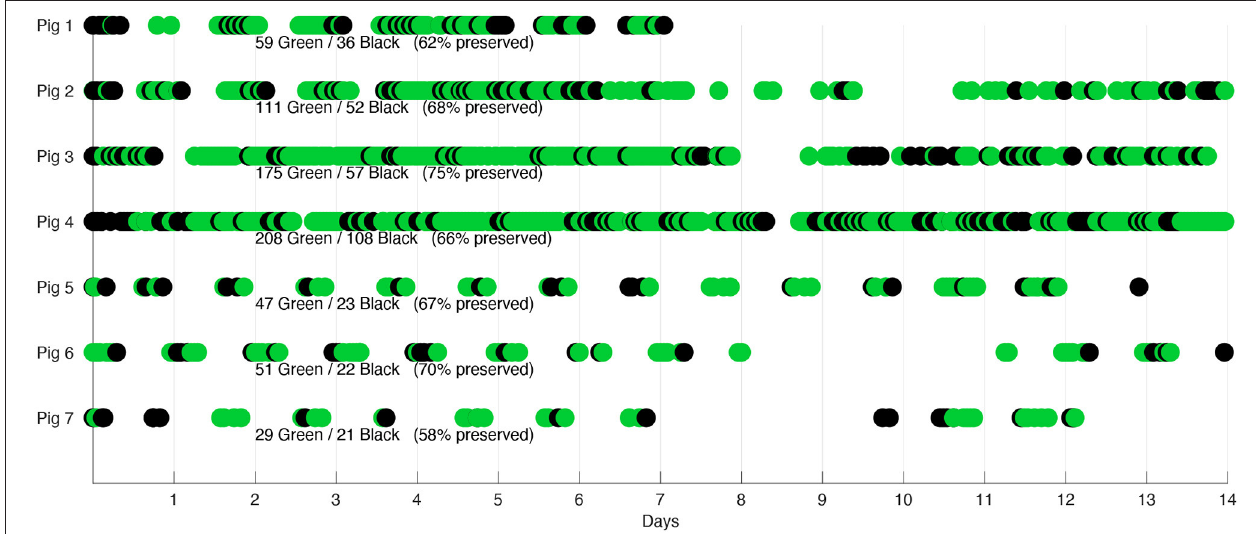
FIGURE 8 | Signal acceptance distribution over time. Green dots represent the recordings finally preserved, black dots represent all discarded